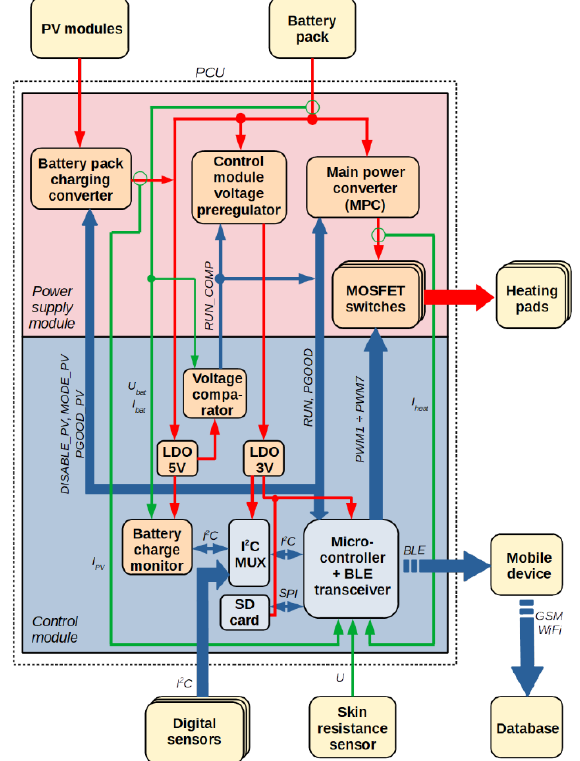
Figure 1. Heating system block diagram (blue: digital signals, green: analog signals, red: power flow).